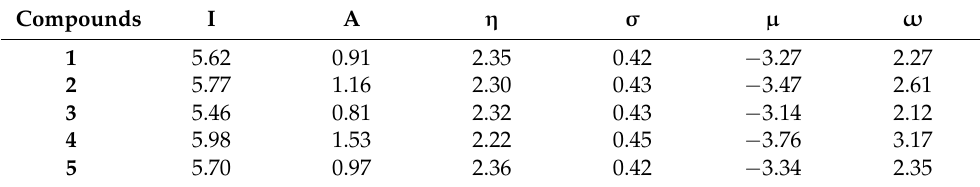
Table 6. The values of reactivity parameters in eV of all the studied compounds ( 1 – 5